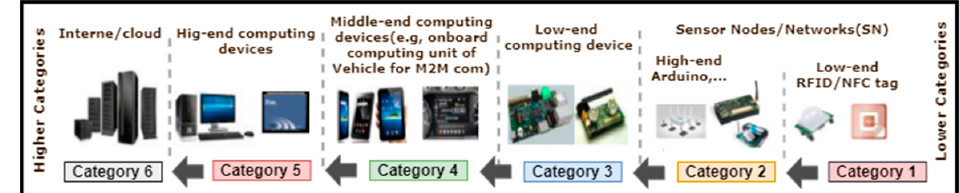
Figure 1. IoT heterogeneity and computing constraints.